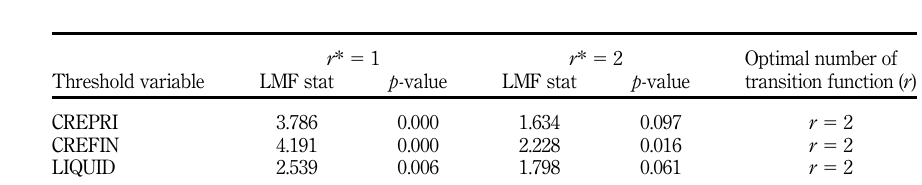
Table 2. Test of no remaining